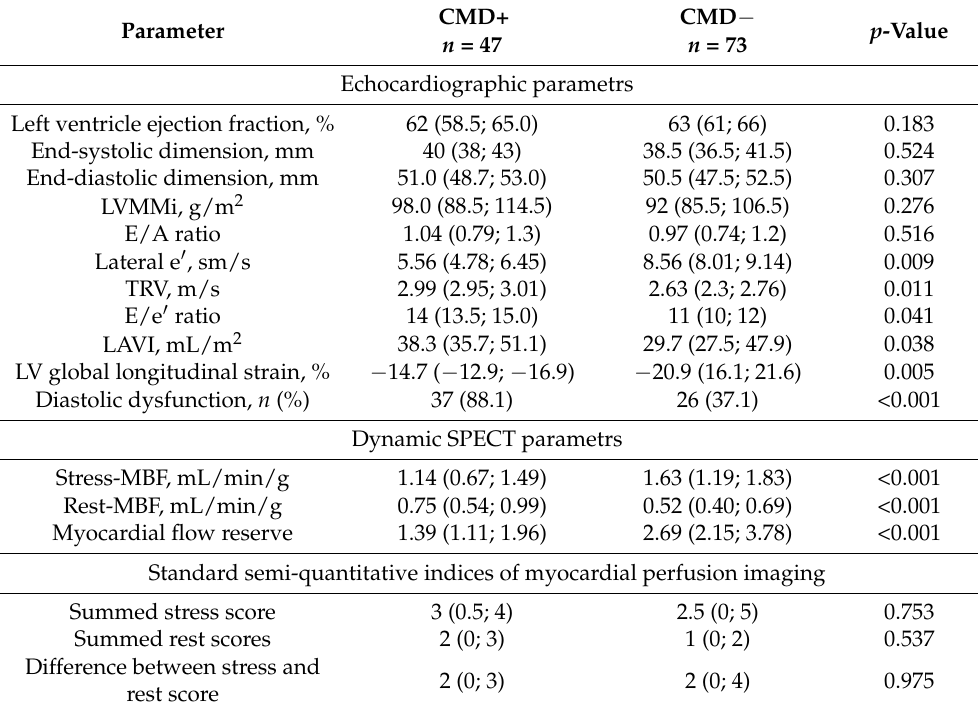
Table 2. Baseline echocardiographic and dynamic SPECT